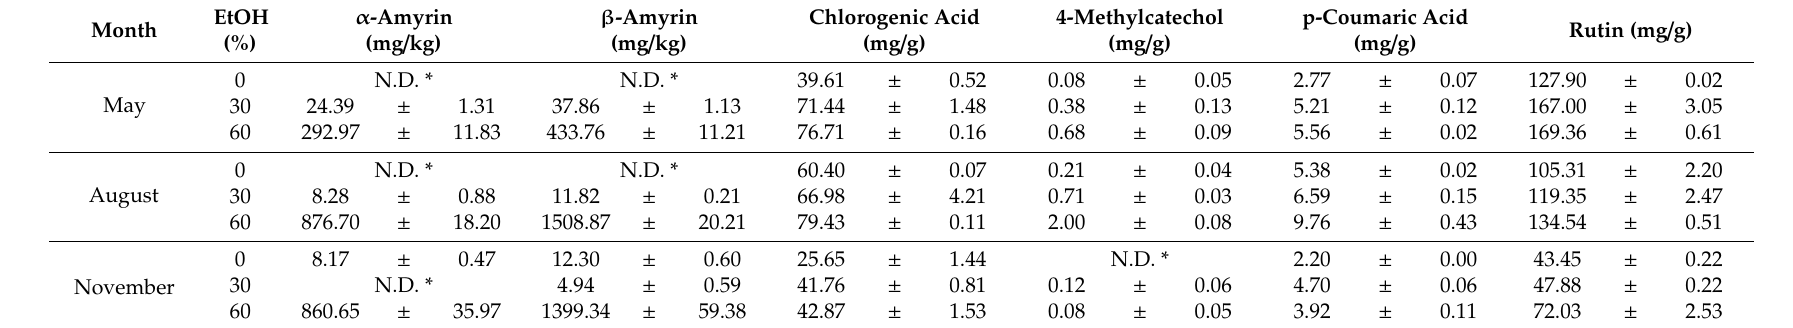
Table 1. Profile and concentration of flavonoid compounds in Dendropanax morbifera